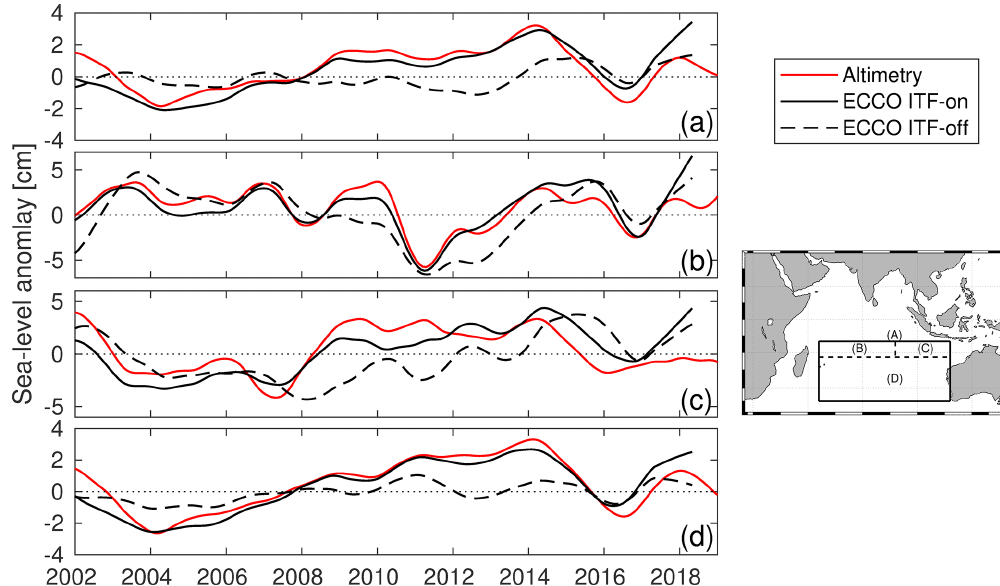
Figure 4. Time series of the sea level anomaly (SLA) from altimetry (red line) and from numerical simulations (ITF-on: black line; ITF-off: black dashed line). The SLA (a, b, c, d) are averaged in four areas (A, B, C, D, respectively) represented in the map on the right panel. All the time series are low-pass filtered with a cutoff period of 1